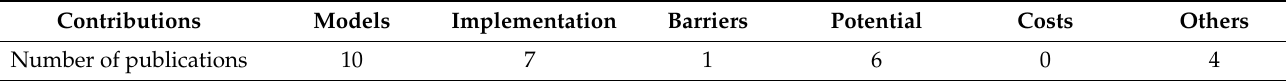
Table 7. Research works independent of location.